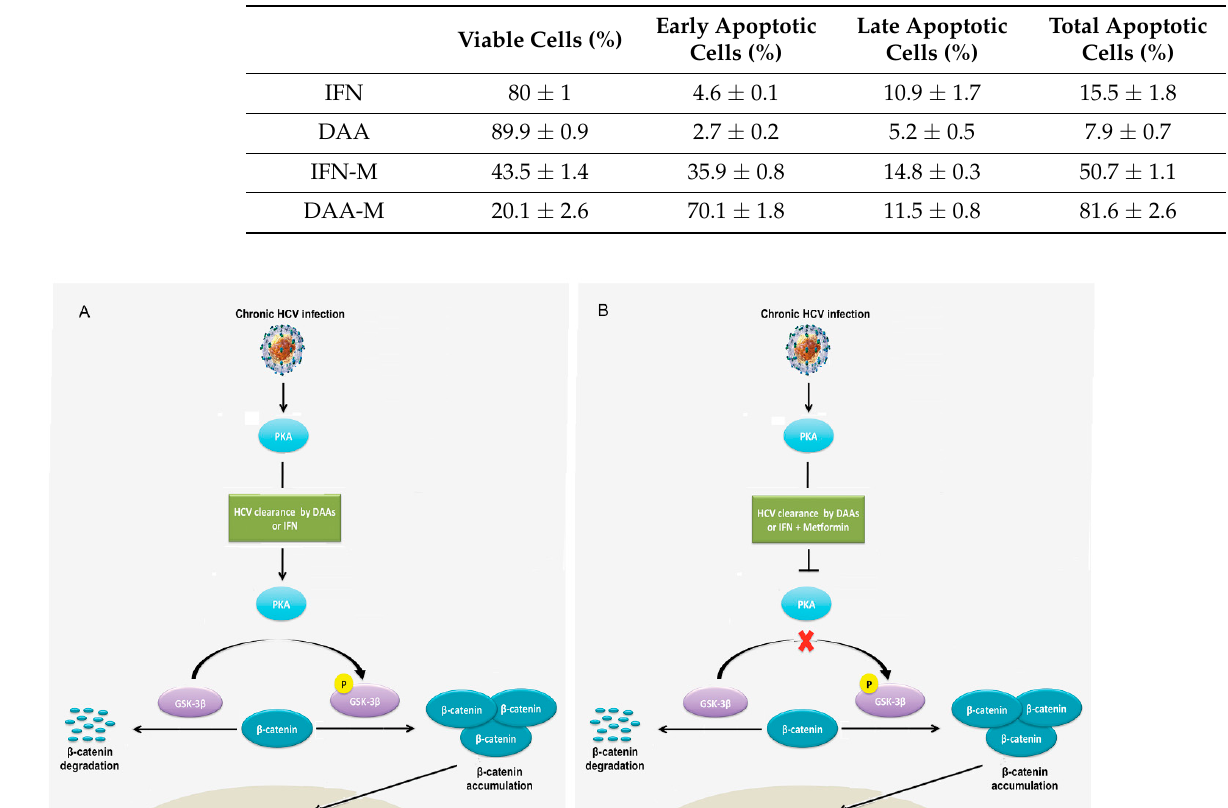
Table 2. Apoptotic analysis of chronic HCV-infected cells treated by either interferon- α (IFN) or direct-acting antiviral agents (DAA) alone and in combination with metformin (M) using annexin V-FITC flow cytometry demonstrating viable cells and cells in early and late apoptosis.